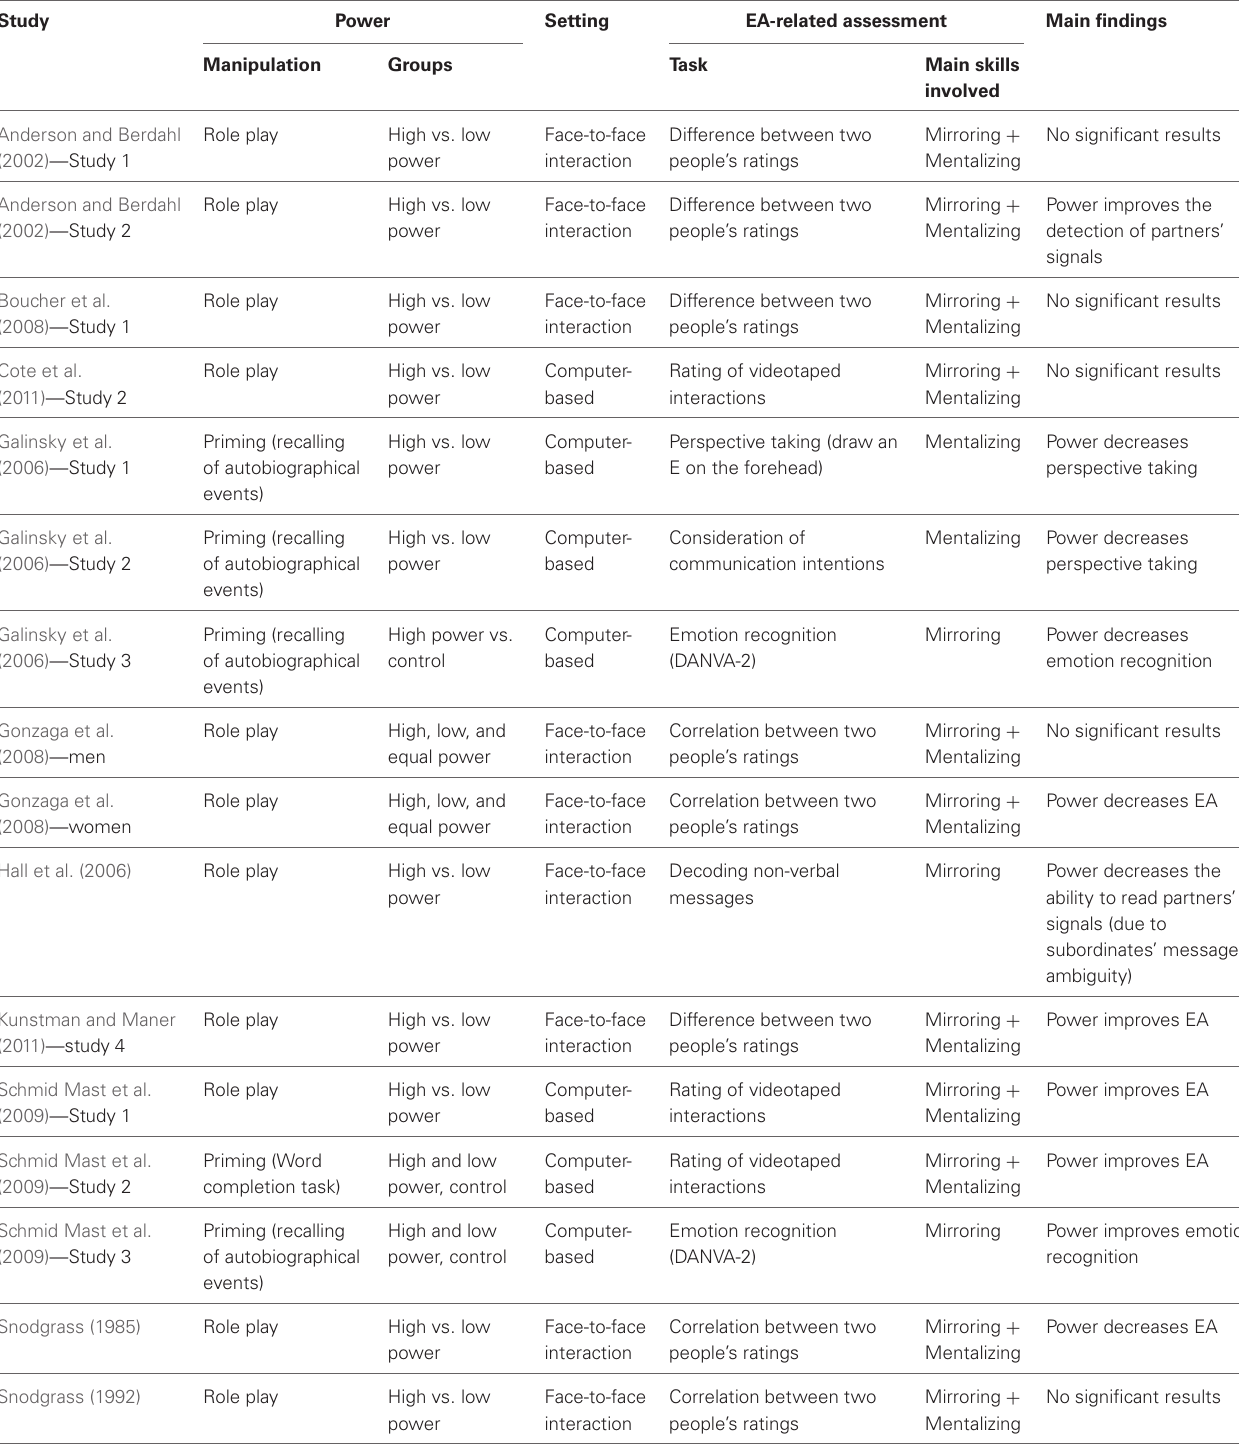
Table 1 | An overview of the studies investigating the relationship between power and